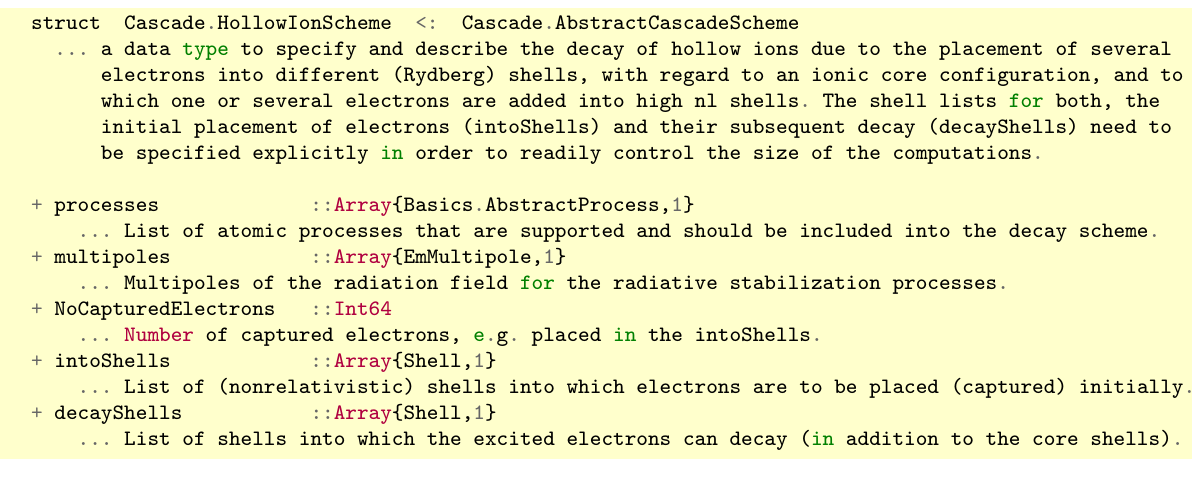
Figure 3. Definition of the data structure Cascade.HollowIonScheme in J AC that helps per- form the cascade computations in Section 3 below. It selects one of the possible schemes of a Cascade.Computation and enables the user to specify the atomic processes and the multipole com- ponents of the radiation field that are to be included in the nonradiative and radiative stabilization of ions. Apart from the hollow-ion cascade scheme above, Table 1 displays several other data structures that are relevant for the computation and analysis of photon emission (or electron) spectra. They are explained just briefly here, while further details can readily be obtained from the J AC toolbox manual [30] or by using Julia’s help facilities [32]. Nonetheless,